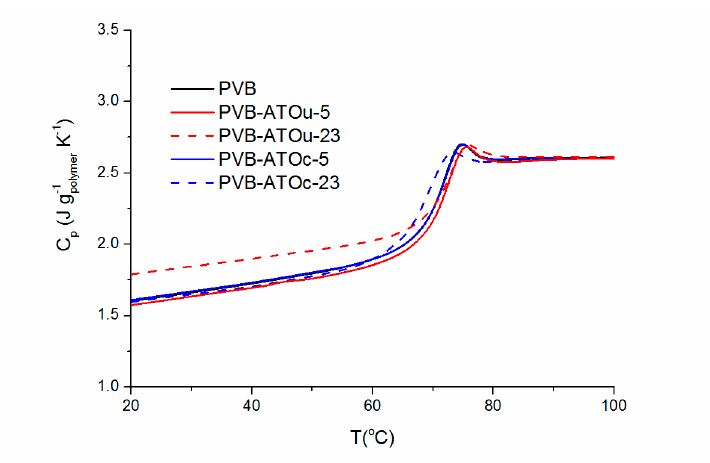
Figure 7. Differential scanning calorimetry (DSC) curves recorded for the PVB and PVB ‐ ATO nanocomposites (second heating cycle). The specific heat capacity of the polymer fraction in the nanocomposites is shown and the curves are aligned to the specific heat capacity of the pure polymer above the glass transition as described in the Materials and Methods section.